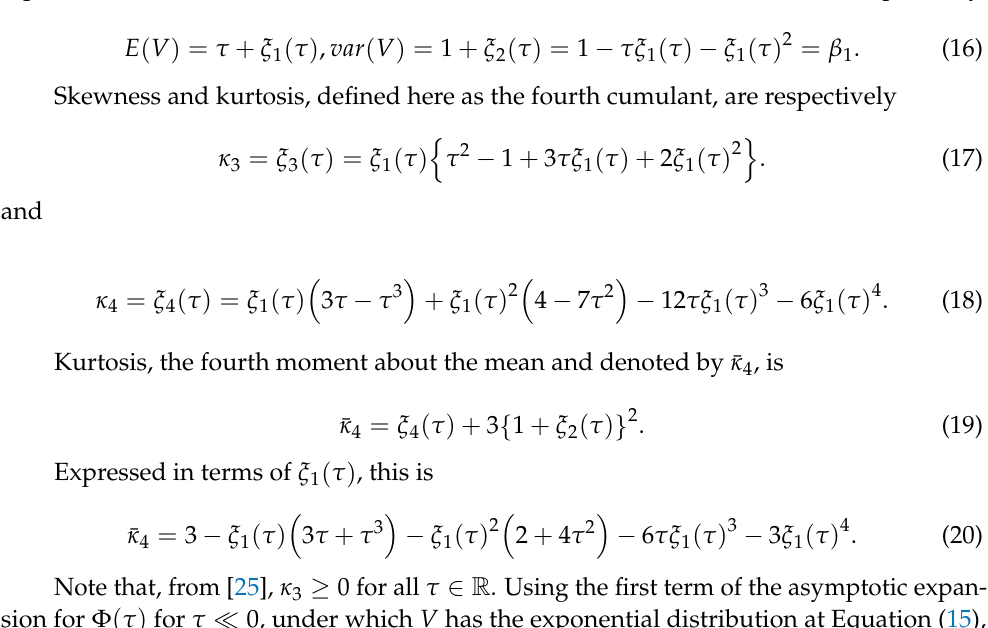
Figure 3. Truncated normal density function τ = − 3 and